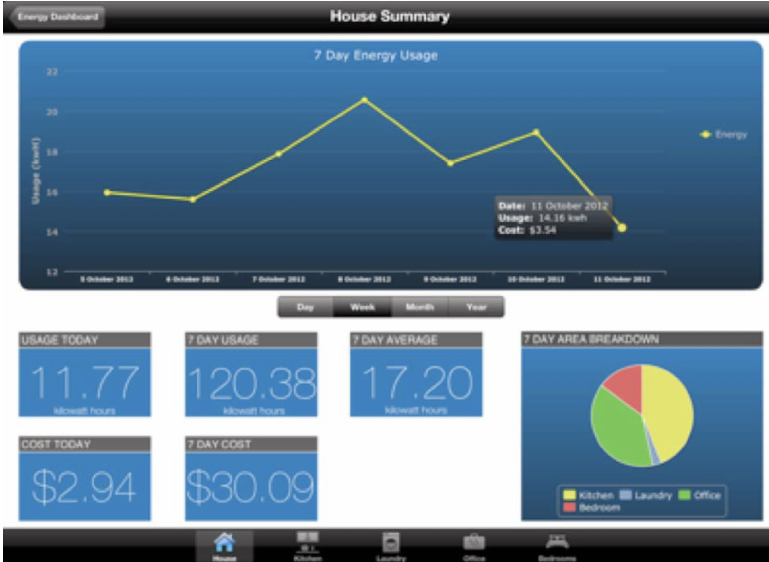
Figure 10. An example of an interactive visualization used for analysis as part of the dashboard tool shown in Figure 3. Image from Reference